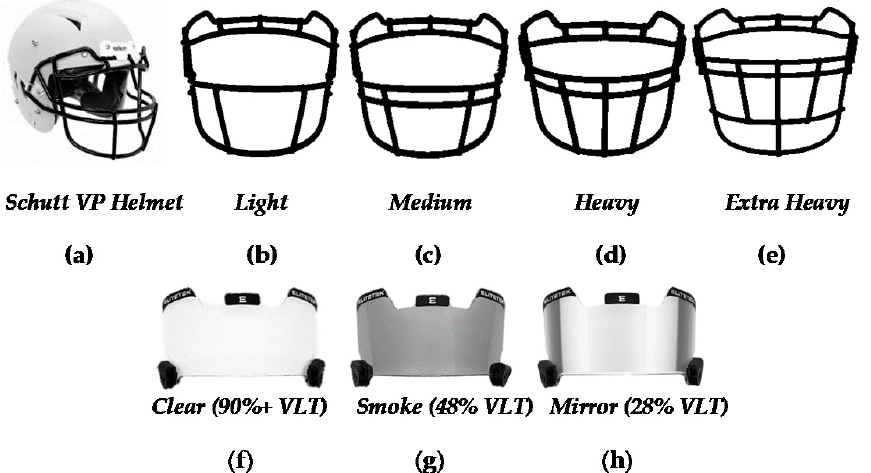
Figure 1. Protective football headgear: ( a ) Schutt™ Custom Vengeance Pro Helmet, ( b ) light rein- forced facemask (V-ROPO-DW-TRAD), ( c ) medium reinforced facemask (V-ROPO-TRAD), ( d ) heavy reinforced facemask (V-ROPO-SW-TRAD), ( e ) extra-heavy reinforced facemask (VR JOP DW TRAD), ( f ) Elitetek clear football visor (90%+ visual light transmittance; VLT), ( g ) Elitetek smoke-tinted football visor (48% VLT), ( h ) Elitetek mirror-tinted football visor (28% VLT).